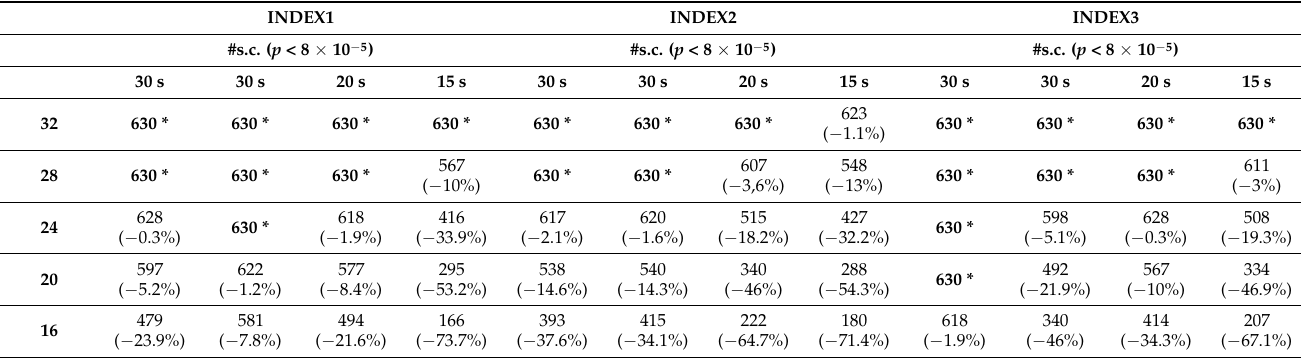
Table 4. Number of significant correlations (#s.c.) and eventual decreasing as percentage of the total number of combinations (630) for the three indices (INDEX1, INDEX2, INDEX3) and the five subgroups of subjects (32, 28, 24, 20, 16) during SPOT1 (30 s), SPOT2 (30 s), SPOT3 (20 s), and SPOT4 (15 s).